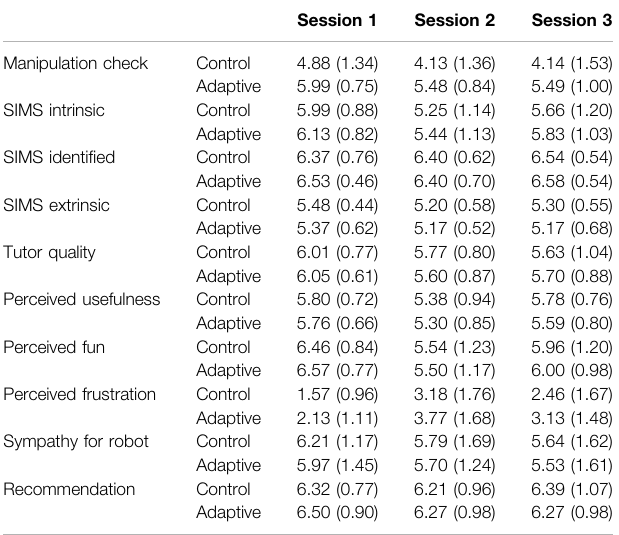
TABLE 3 | Mean values for questionnaire measures across both conditions each on a scale of 1 – 7. Standard deviations in